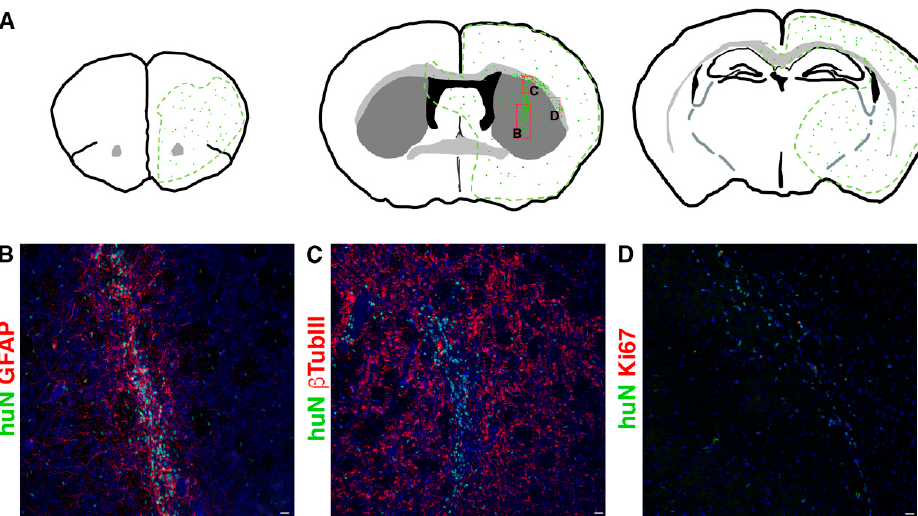
Figure 2. ( A ) Schematic showing typical migration patterns of hNSCs transplanted into the striatal region of the brain (( A ), middle). The area outlined in green represents the main brain areas reached by hNSCs (symbolized by green dots). Red boxes indicate the position of pictures showed in ( B , C , D ) respectively. ( B – D ). Transplanted hNSCs, huN + (green in ( B – D )), engraft the striatum (graft core in ( B , C )) and migrate in the surrounding parenchyma (single huN+ cells in ( B , C )) and along the corpus callosum ( D ). The cells express astrocyte markers (GFAP, red in ( B ), neuronal markers (bTubbIII, red in ( C )) and the proliferation marker Ki67 (red in ( D )). Scale bar in ( B – D ): 20 µm. In order to determine the fraction of proliferating cells in situ, we performed immunostaining for the human proliferation marker Ki67. The hNSC lines never showed signs of tumorigenic transformation in long-term experiments and the proliferating cell fraction never exceeded 7% (Supplementary Table S3).